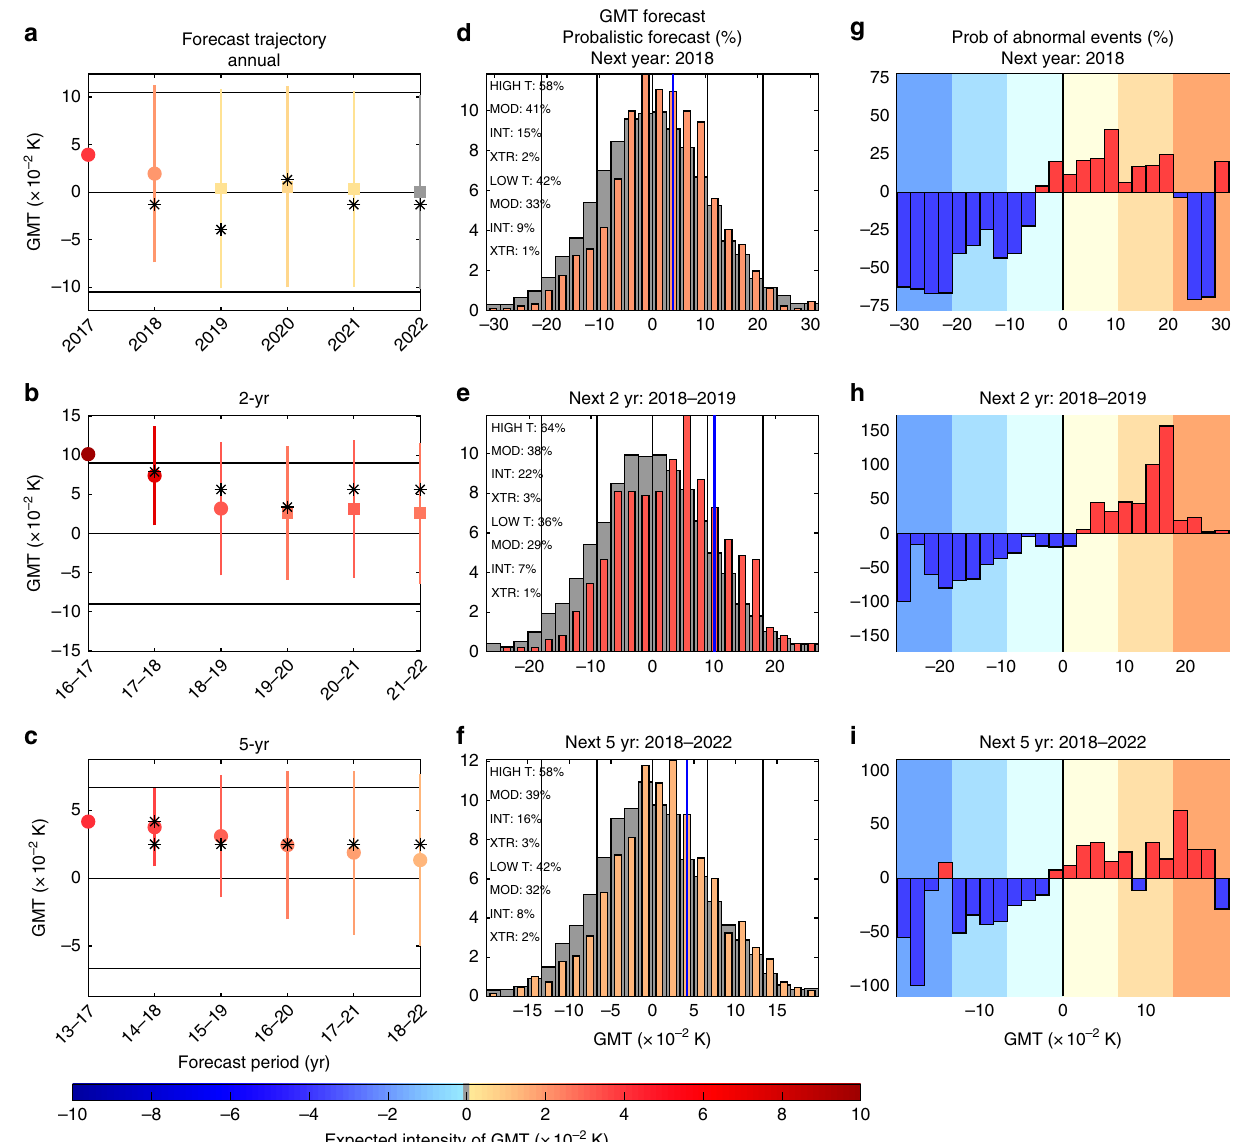
Fig. 7 Interannual probabilistic forecast of the GMT anomalies. a – c Mean prediction of GMT anomaly for the next 5 years for three different averaging times: annual, 2, and 5 years; horizontal black lines correspond to the mean and ±1 standard deviations of the climatological distribution. Circles and squares represent mean predictions with coef fi cient of determination bigger and smaller than 0.2 (note that we still have good reliability even for skills smaller than 0.2); colorscale represents the mean prediction of the GMT anomaly; the vertical colored lines represent ±1 standard deviation of prediction distributions. Stars denote the most likely state from the distributions. d – f Prediction of GMT distribution (in %) for 1, 2, and 5 years in advance with respect to 2017. Gray histograms in the background represent the asymptotic, climatological distribution; vertical blue lines represent the current position used to initialize the forecast system; vertical black lines correspond to the mean, ±1, and ±2 standard deviations of the climatological distribution. g – i Distribution of probability anomaly (in %), probability changes with respect to the climatological distribution, for the 1, 2, and 5 years in advance predictions. Background colorscale represents ±0 – 1, 1 – 2, and more than 2 standard deviations, respectively, consistently with moderate, intense,